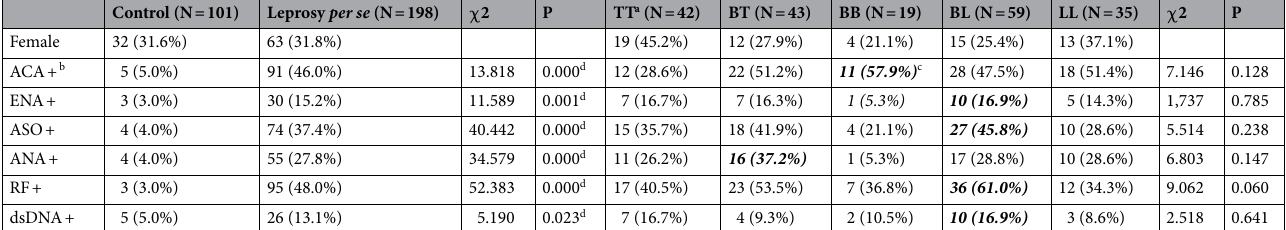
Table 2. Positive rate of ACA-IgG, ENA-Ab, ASO-Ab, RF-IgA, ANA-Ab, dsDNA-Ab, LACC1-Ab in the plasma of cured leprosy patients and controls. a TT, tuberculoid leprosy, BT, borderline tuberculoid leprosy; BB, mid-borderline leprosy; BL, borderline lepromatous leprosy; LL, lepromatous leprosy; b +, positive, an individual with the plasma level of an autoantibody higher than the mean + 2 SD (standard deviation) level of that of the control group was defined as positive for the autoantibody. c Highest rate in the five subtypes were marked in bold and italic. d Comparisons of the positive rate of each autoantibody between control and patients groups were conducted using correct Chi-Squared Test of four-fold table, in five subtypes were conducted using Chi-Squared Test of contingency table. A P value < 0.05 was considered to be statistical significance.